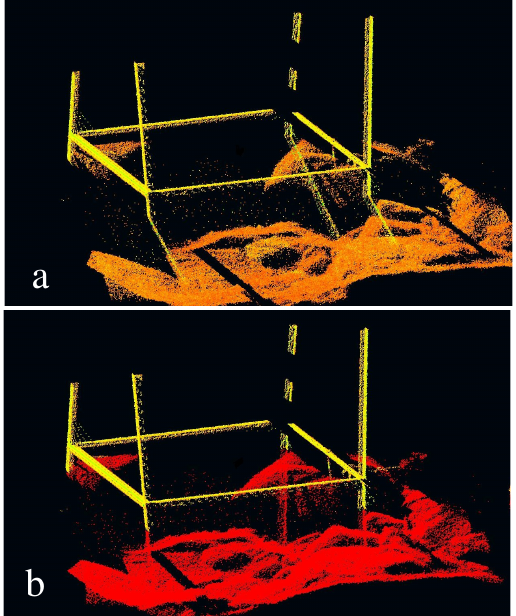
a Figure 3. Point cloud before (a) and after (b) the water refraction correction. Uncorrected underwater data (submerged frame posts and stream-bed point cloud) appear to be higher than the actual position and away from the scanner origin.